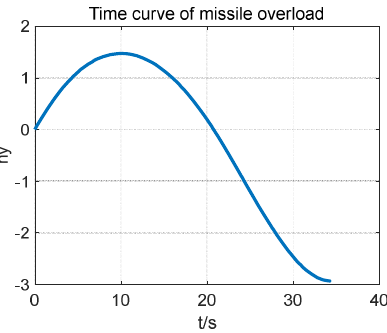
Figure 2. Time curve of missile overload.